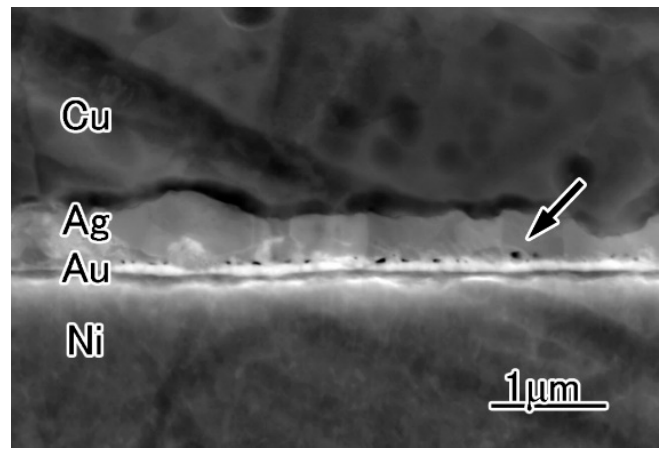
Figure 7. Enlarged SEM image of the interface. The arrow denotes a small pore at the interface.